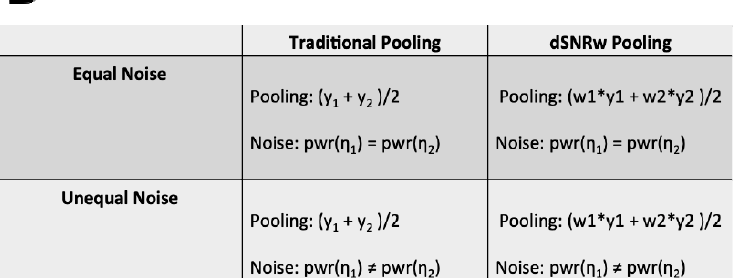
Figure 2. Overview of simulation process. ( A ) Template ERP waveforms derived from healthy participants were combined with simulated noise signals to create channels of simulated ERP data. ( B ) Simulated channels of data were generated under two scenarios—(1) with the power of the noise being equal in both simulated channels, and (2) power of the noise being unequal in the two simulated channels, and data from both scenarios were combined using the traditional channel pooling and the dSNRw techniques.